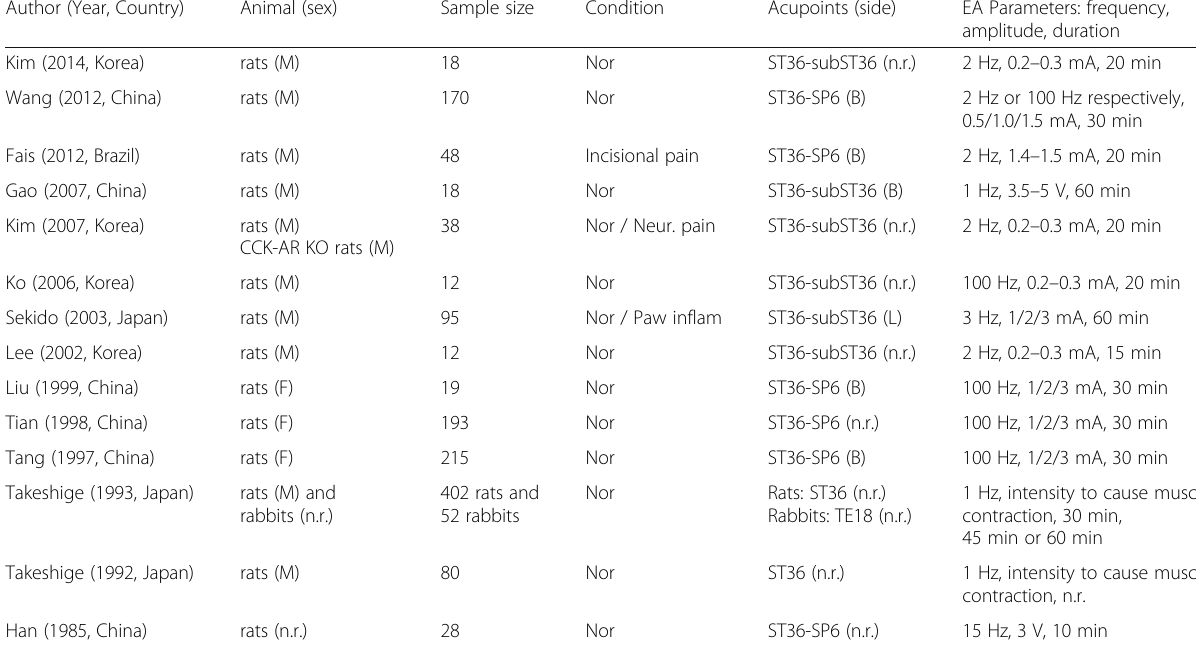
Table 1 Experimental index for electroacupuncture